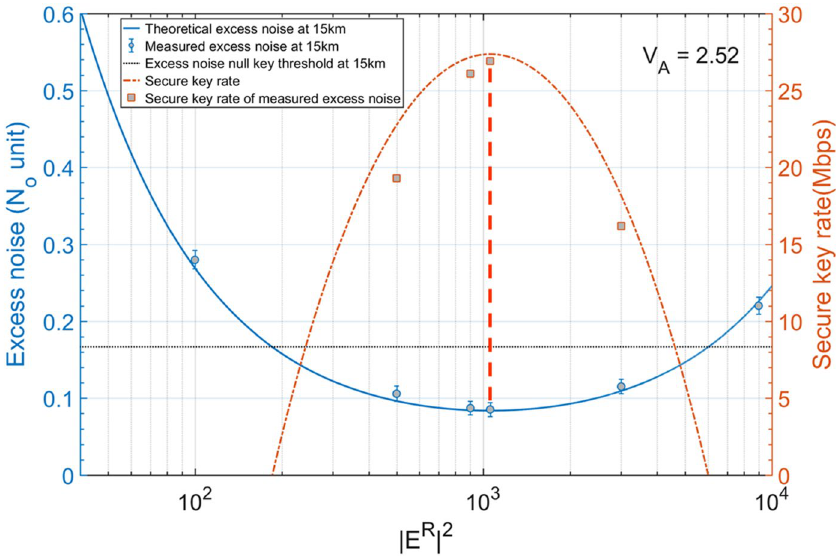
Figure 3. Experimental validation of noise model and optimization method by collecting excess noise at 2 E R different with a fixed optimal V A = 2.52 and L = 15 km. The blue solid line represents the theoretical excess noise evaluation and the grey circles with ± 0.01 error bars denote the measured excess noises with a data block (cid:31) (cid:31) size of 10 7 . The dashed orange line represents the theoretical secure key rate performance and the grey squares (cid:31) (cid:31) are the corresponding secure key rate with measured excess noises. The black line is the null key threshold with ξ e =0.167. The peak secure key rate occurs at the minimum excess noise point with parameters are listed in Table 1 in the “Methods”